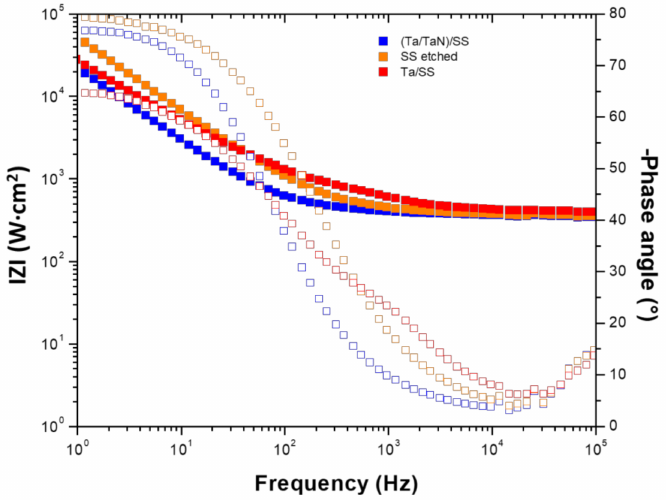
Figure 2. Bode diagram of stainless steel substrates of the following types: etched SS, Ta/SS coating, and